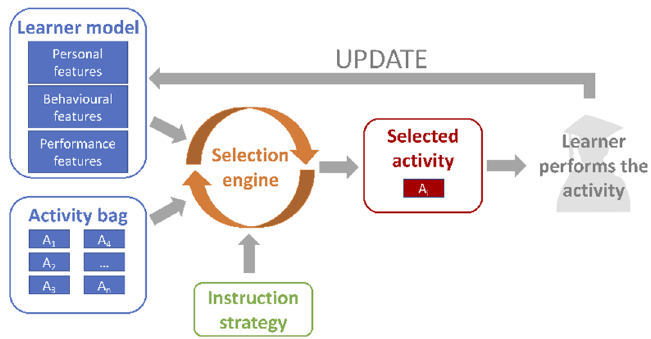
Figure 2. Elements of the smart learning system and process of updating the learner model from the student activity in the system.